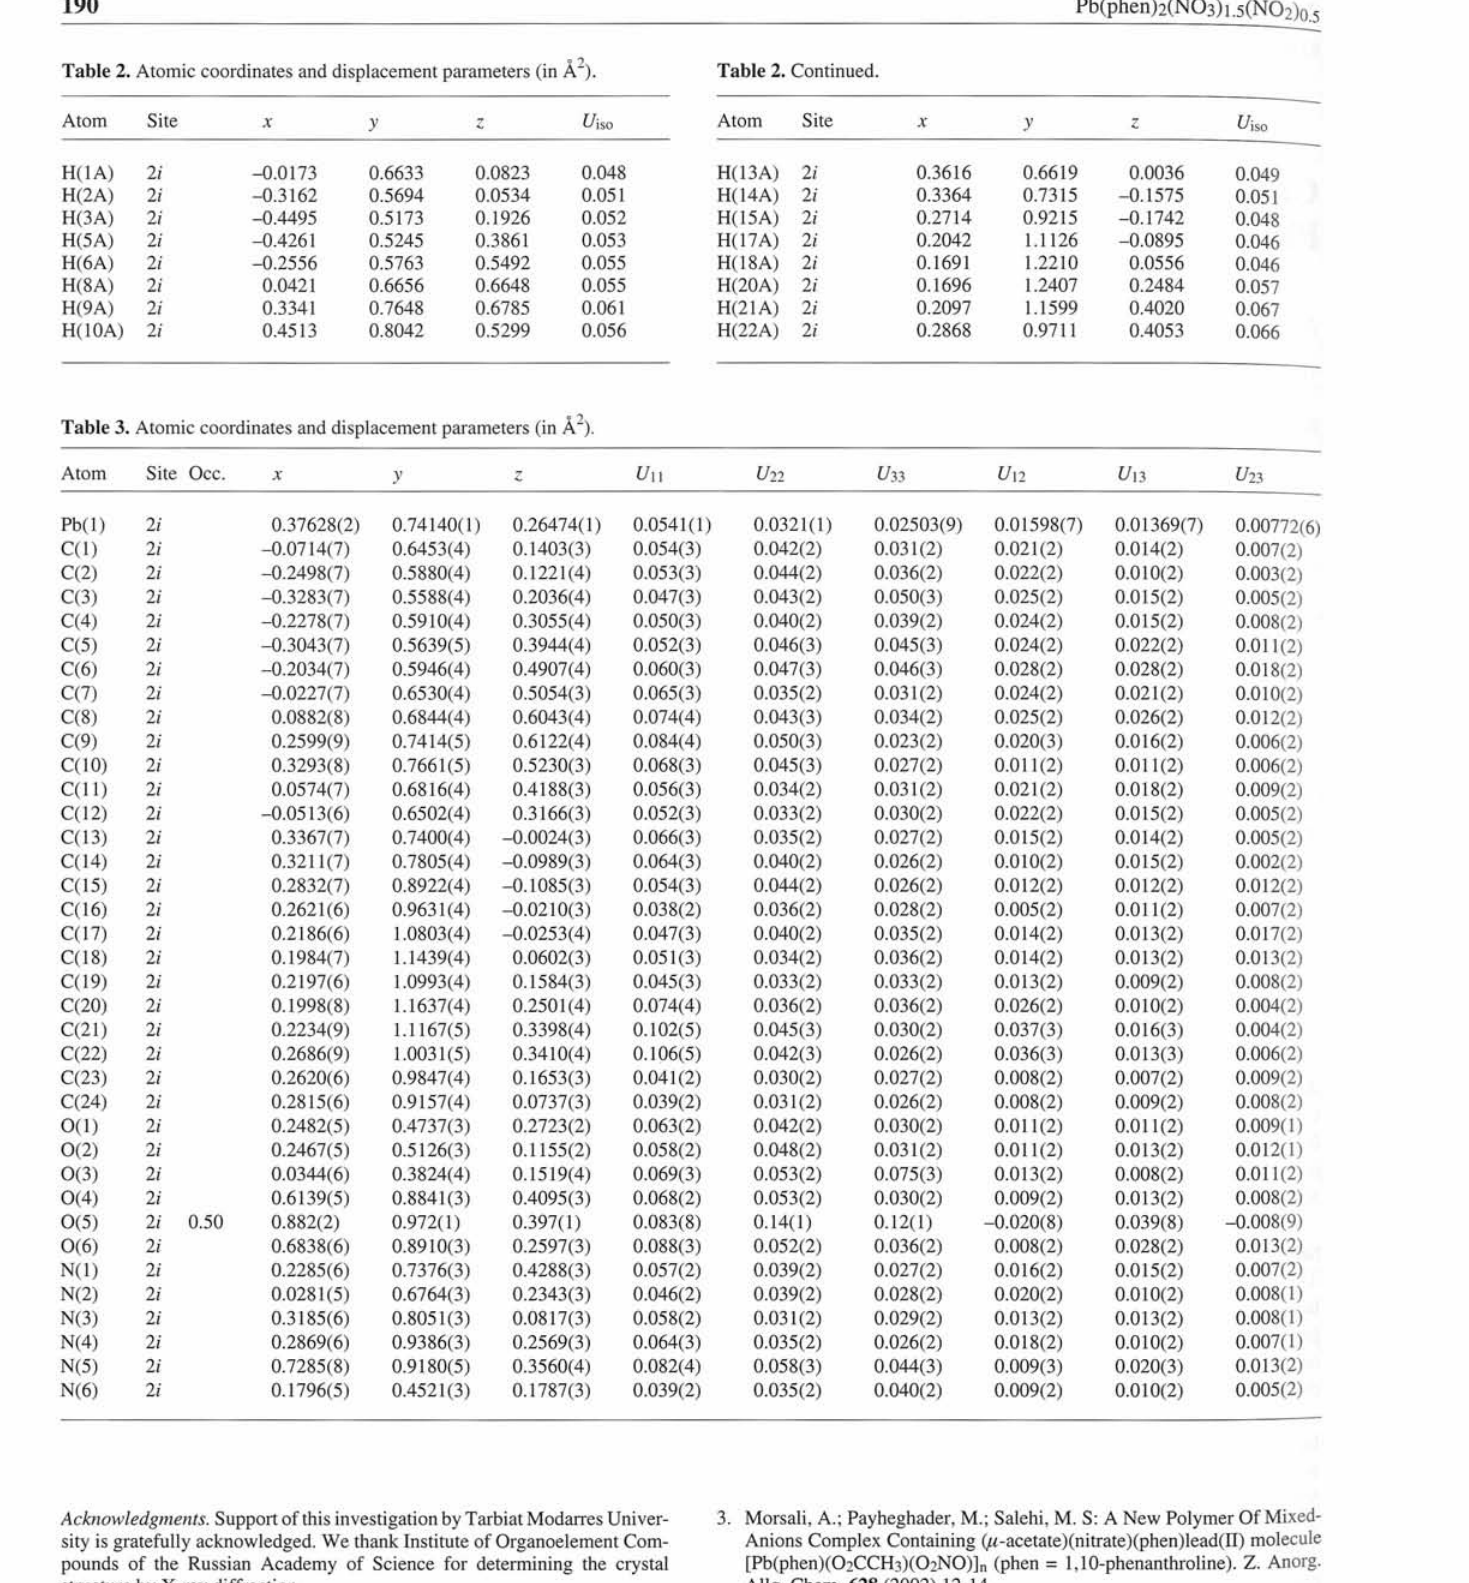
Table 2. Atomic coordinates and displacement parameters (in Â"). Table 2. Continued.